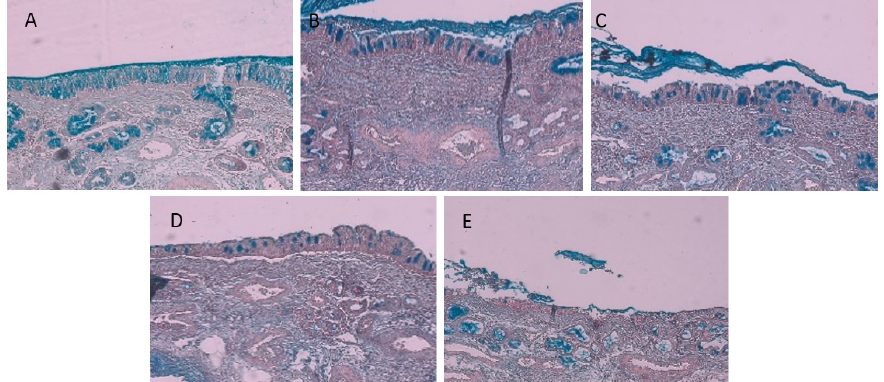
Figure 5. Micrographs of olfactory sheep nasal epithelial tissues of ( A ) the intact control, ( B ) after expo- sure to insulin in the control group, ( C ) after exposure to microparticles consisting of Eudragit ® L100